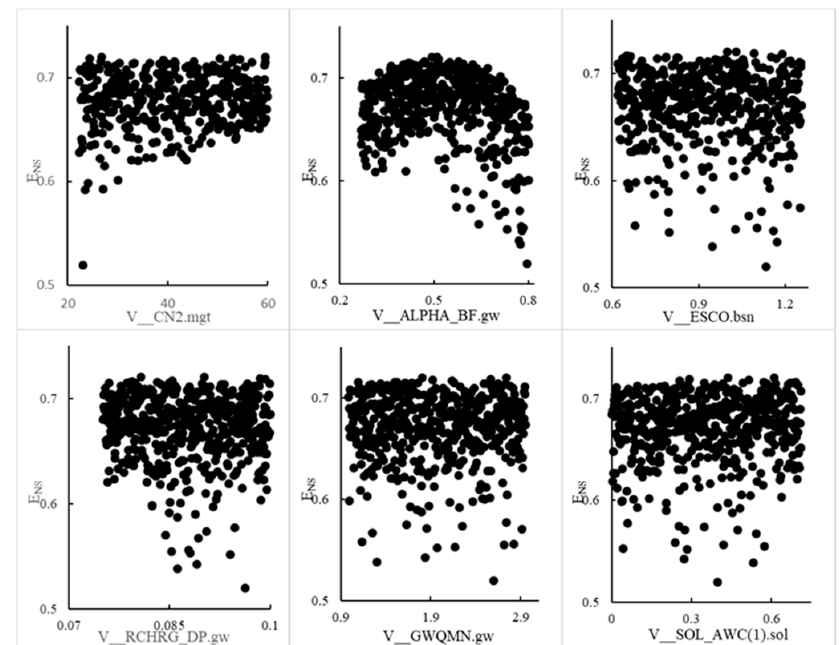
Figure 2. Parameter combination and Nash–Sutcliffe efficiency coefficient distribution diagram of the Xiaoqing River basin based on the SUFI-2 method.